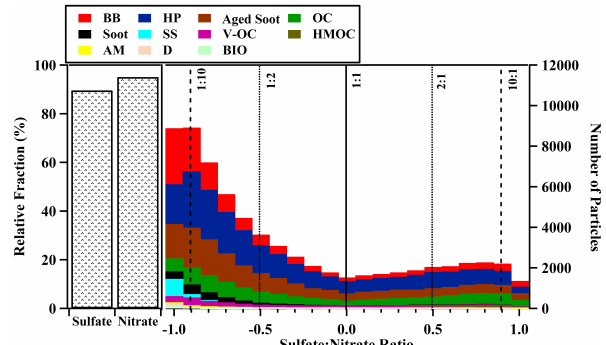
Fig. 4. Fraction of particles containing soot and OC RPA > 0.5% in southern California (left panel). Single particle OC:soot peak ion ratio distributions are shown in (right panel). Values < 0 indicate more soot than OC on single particles and values > 0 indicate more OC than soot. Ratios representing 1:1, 2:1, and 10:1 are shown by solid, dotted, and dashed lines, respectively.